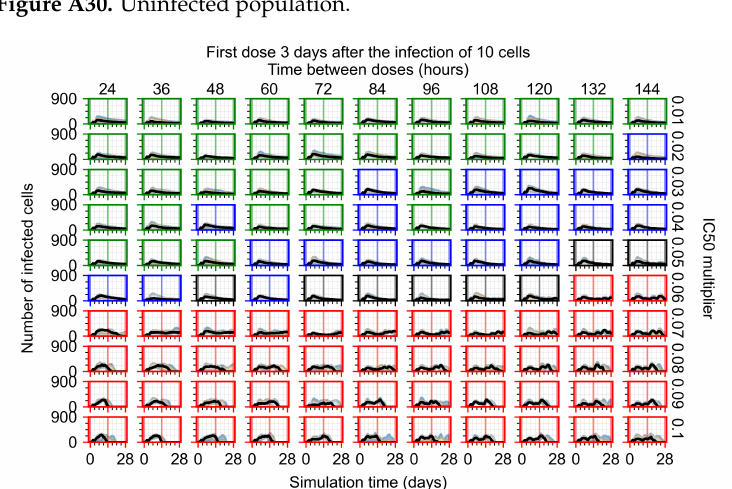
Figure A30. Uninfected population.